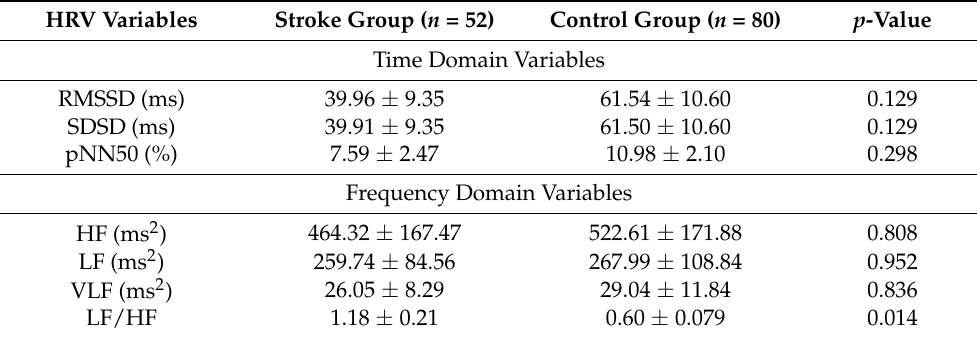
Table 2. Time and frequency domain indices of the heart rate variability (HRV).